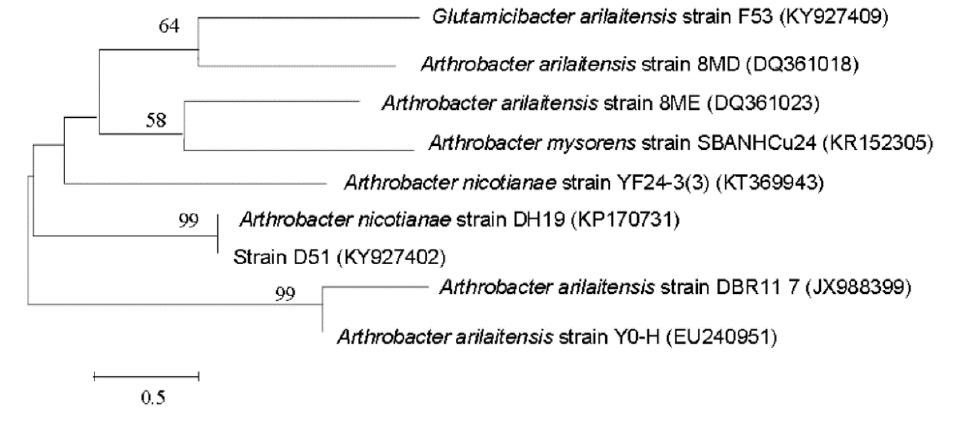
Figure 2. Neighbor-joining phylogenetic tree of Arthrobacter nicotianae D51 and closely related strains. GenBank accession numbers for the16S rRNA sequences used in the tree reconstruction are given in parentheses.